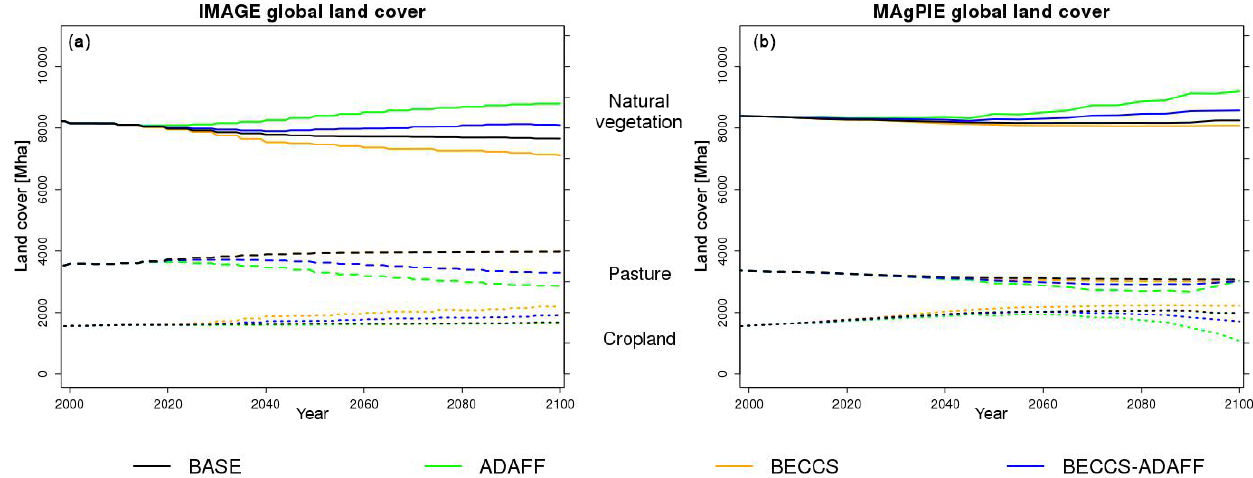
Figure 1. Time series (2000–2100) of area under natural vegetation (including afforested area), pasture (including degraded forest area for IMAGE), and cropland (including bioenergy production area) for the different scenarios, for IMAGE (a) and MAgPIE (b)